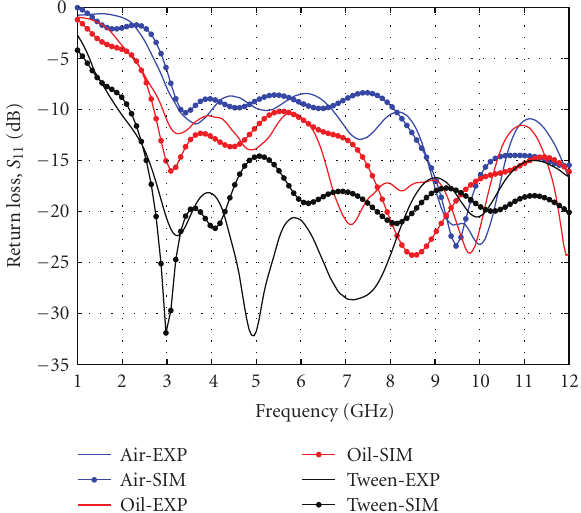
Figure 5: Return loss of elliptical antenna for di ff erent loads.